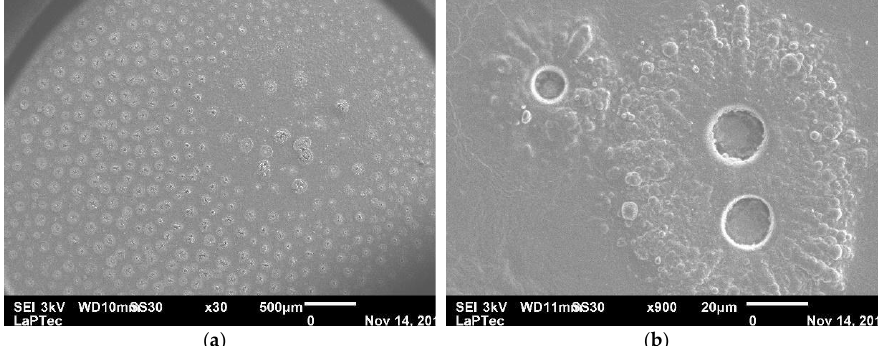
Figure 2. Scanning electron microscopy (SEM) micrographs of the film deposited on stainless steel slide during 45 min with ( a ) 30× and ( b ) 950× magnifications.